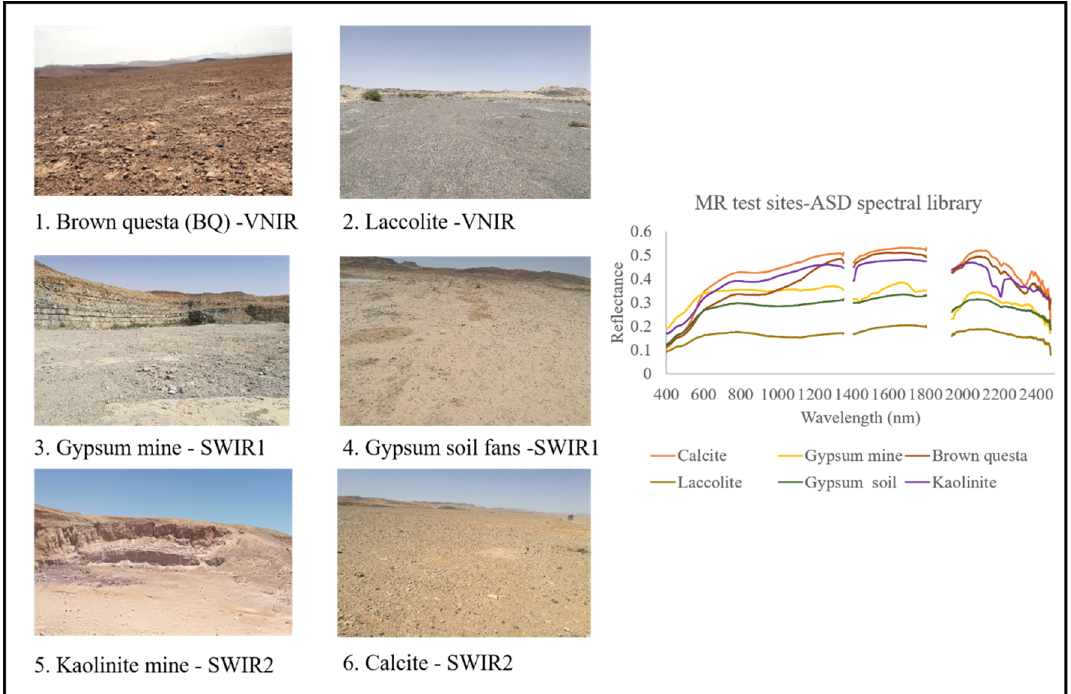
Figure 2. MR test sites. Different mineralogies and spectral signatures characterize the 6 test sites. Spectral signatures are from the spectral library acquired using an Analytical Spectral Devices (ASD) spectroradiometer.